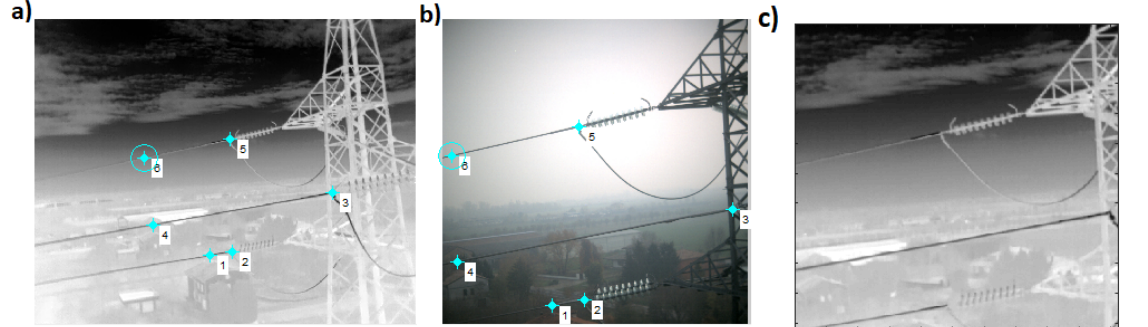
Figure 6. Image registration by user-defined control point selection to fuse multiple images from IR and visible cameras. We manually selected the significant feature from both IR and visible images which correspond to each other: ( a ) Control point selection from IR image. IR image has larger FOV (field of view), so we selected IR image to be registered; ( b ) Control point selection from Infrared image; ( c ) IR image after registration.